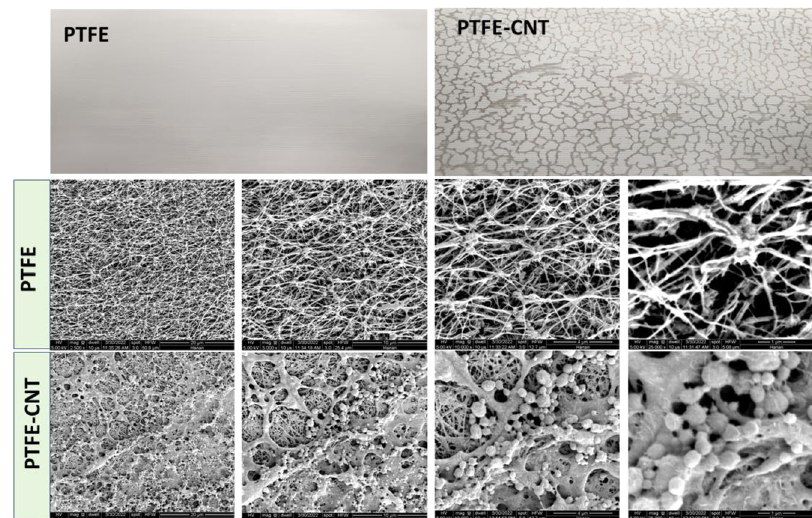
Fig. 2 Photo snaps and SEM Images of PTFE membrane and electrosprayed PTFE-CNT membrane at different magni fi cations.